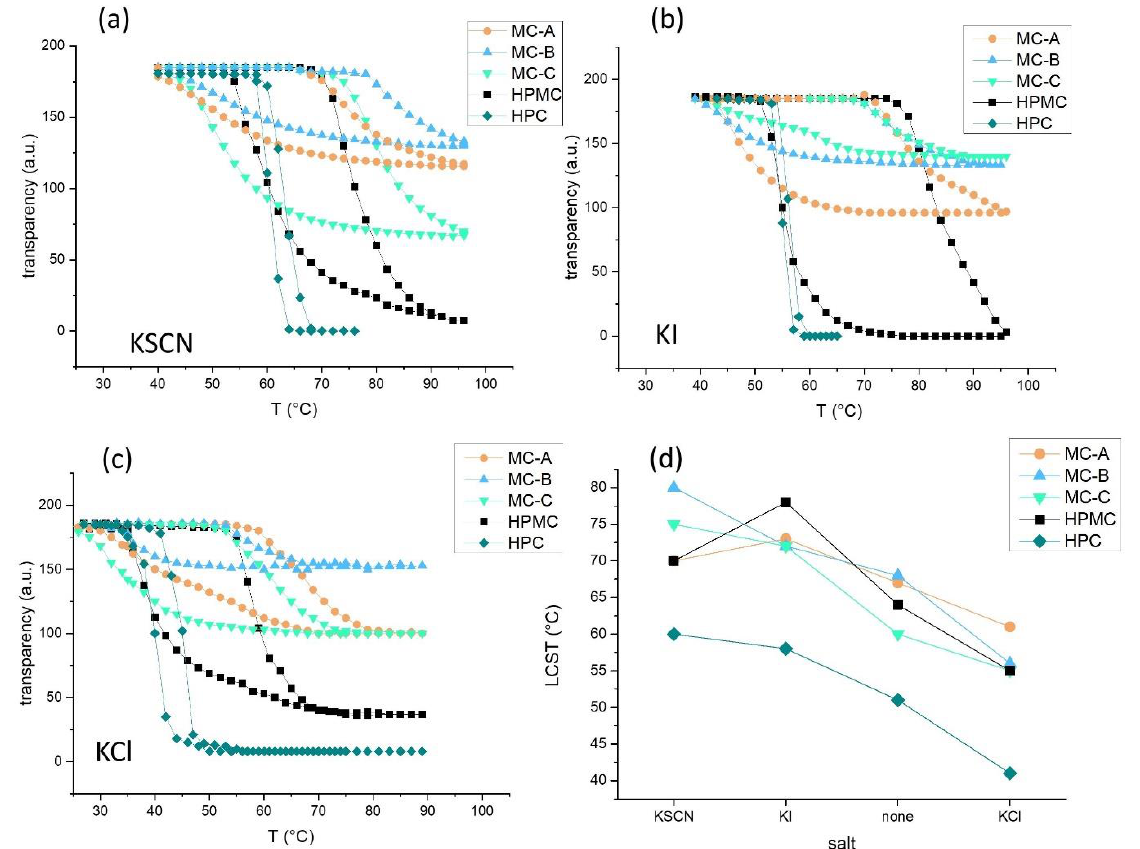
Figure 4. Transparency as a function of temperature during a thermal cycle from heating to cooling at 1 °C/min for 1 wt % aqueous solution of cellulose ethers with addition of KSCN ( a ), KI ( b ) and KCl ( c ) at the concentration of 0.5 sM. In frame ( d ) the variation in LCST without and in the presence of salts is reported. Table 2. Main characteristics of the (hydroxypropyl)methyl cellulose batches selected for this study.